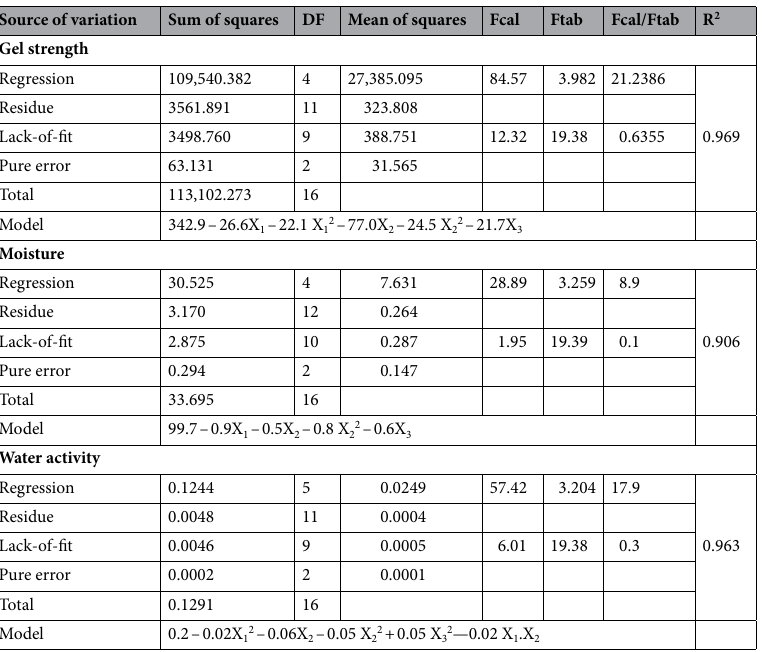
Table 6. Analysis of variance and model of gel strength, moisture, and water activity of the independent variables, F test, and R 2 of the combined process. Fcal calculated F, Ftab tabulated F, DF degrees of freedom,